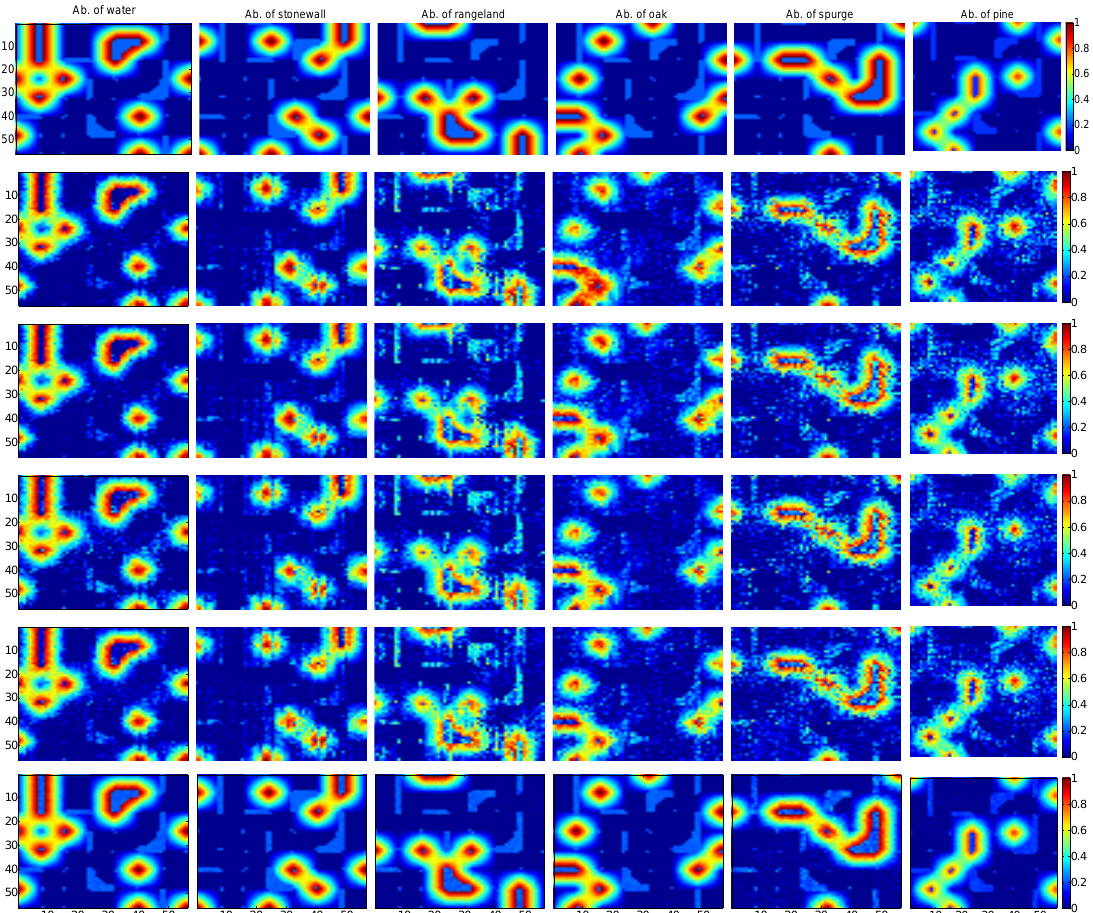
Figure 2. Abundance maps estimated by the compared methods and the proposed method in the presence of three types of noise. From top to bottom: ground truth, FCLS, GDA, semi-NMF, BPOGM and